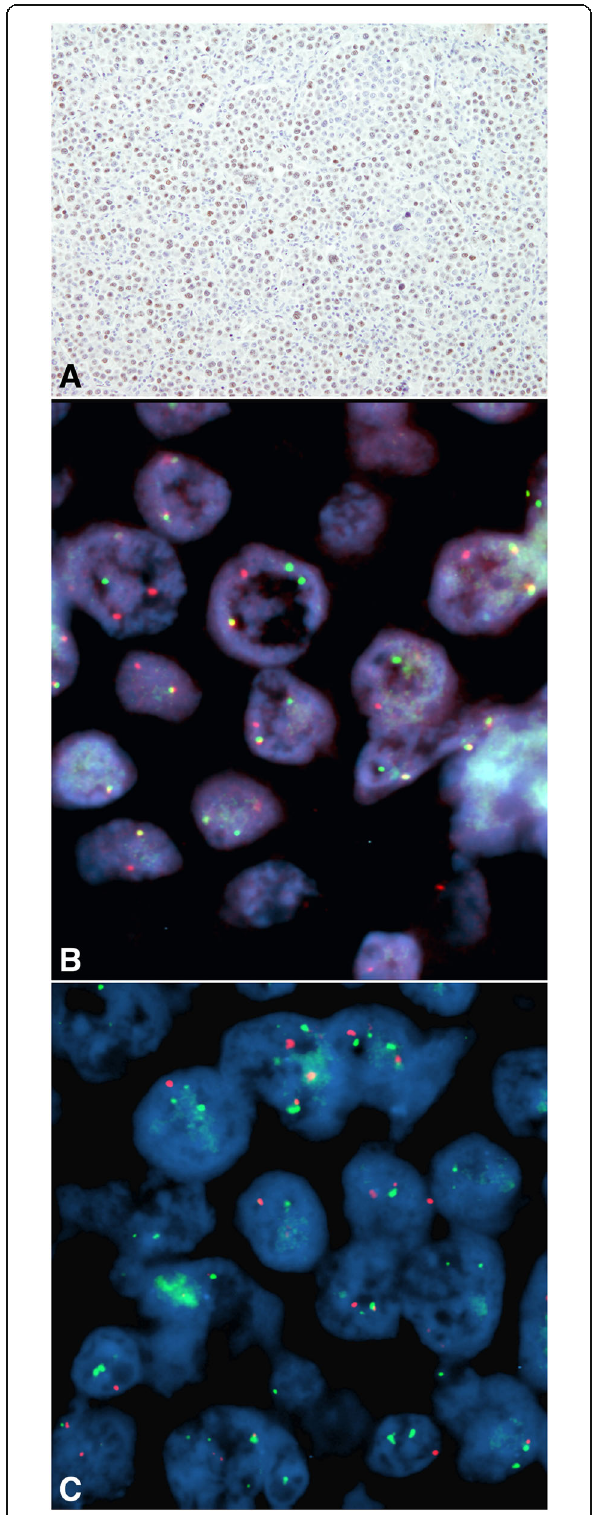
Fig. 3 MYC immunohistochemistry and fluorescent in situ hybridization (FISH). a Large atypical plasmablasts were c-MYC positive in >40% of cells. b FISH analysis using Vysis MYC Break Apart FISH Probe Kit revealed 8q24 rearrangement within tumour cells (cells without rearrangement should have 2 yellow fusion signals; magnification × 1000). c FISH analysis using Vysis LSI IGH/MYC , CEP 8 Tri-color Dual Fusion Translocation Probe is negative for t(8,14), without yellow signals specific for IGH/MYC translocation (normal 2 green ( IgH ) and 2 red ( MYC , 8q24) signals); magnification ×